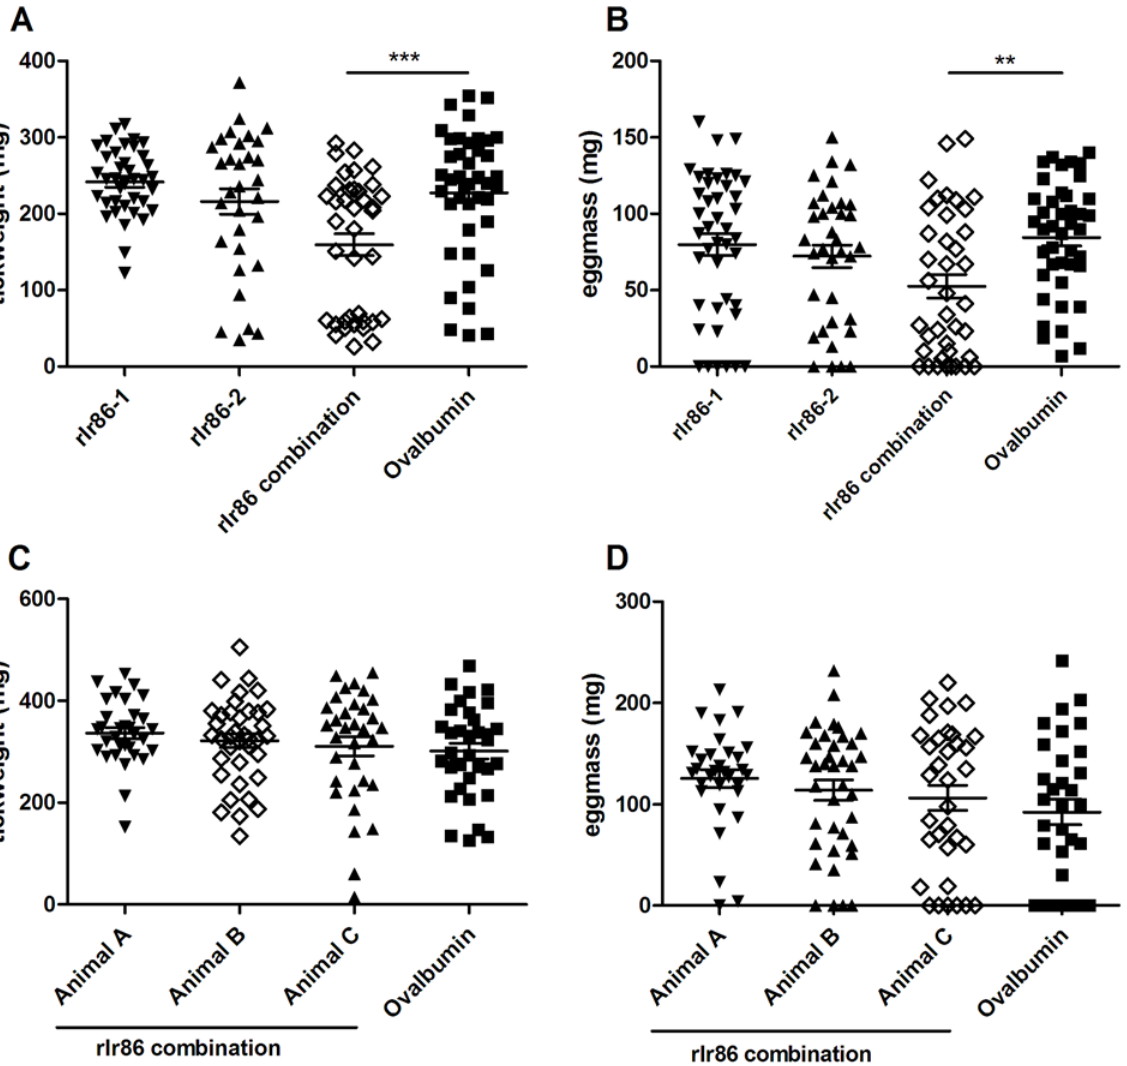
Fig 3. I . ricinus infestations on rIr86-1, rIr86-2 or rIr86-combination vaccinated rabbits. Rabbits were infested with 50 I . ricinus adult females and 50 I . ricinus adult males two weeks after the second boost (t = 56) in a pilot experiment (experiment A) and a confirmatory experiment (experiment B). Each column on the x-axis represents one animal in experiment A (A and B) or experiment B (C and D). A. Post feeding female tick weight in experiment A, each dot represents one tick. B. Egg mass from experiment A. Fed adult female ticks were stored individually. After 6 weeks, egg mass was weighted. Each dot represent egg mass from one female tick. C. Post feeding female tick weight in experiment B. D. Egg mass from experiment B. Error bars represent mean ± SEM. Mean values significantly different in a one-way analysis of variance (ANOVA) with the Tukey-Kramer multiple-comparison test for multi-group comparisons are indicated by two asterisk (p < 0.01) or three asterisks (p < 0.001).